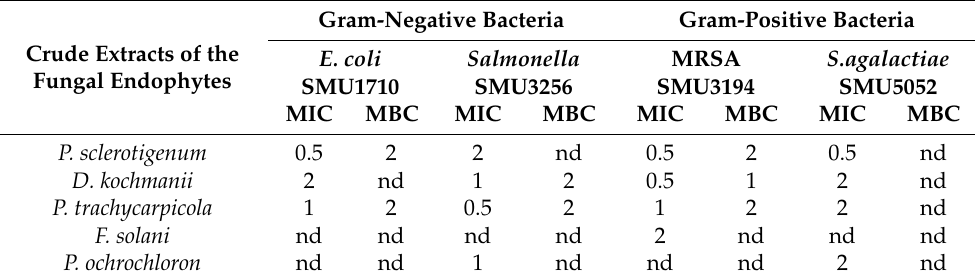
Table 4. Minimum inhibitory concentration and minimum bactericidal concentration (mg/mL) of ethyl acetate extracts from endophytic fungi isolated from A. adenophora against veterinary and clinical multidrug-resistant pathogen isolates.